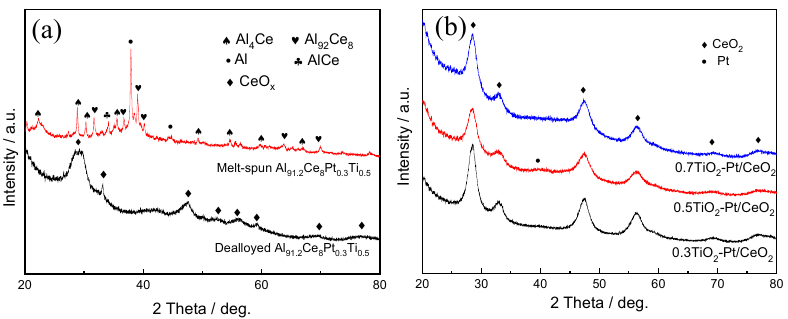
Figure Figure 1. The XRD patterns of ( a ) melt-spun and dealloyed Al 91.2 Ce 8 Pt 0.3 Ti 0.5 ribbons; ( b ) (xTiO 2 − Pt 0.3 )/CeO 2 (X = 0.3, 0.5, 0.7) calcined at 300 °C.